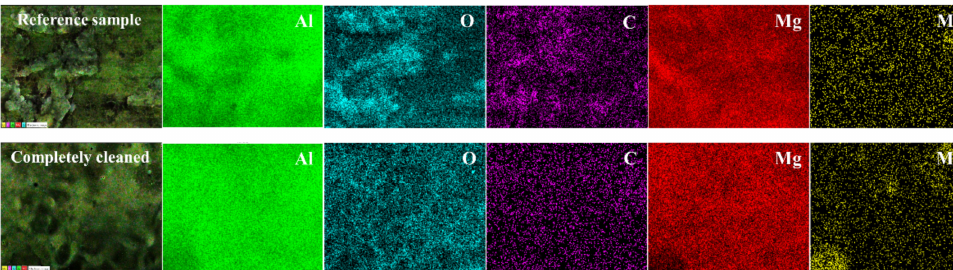
Figure 10. Layered image of uncleaned and completely cleaned aluminum alloy